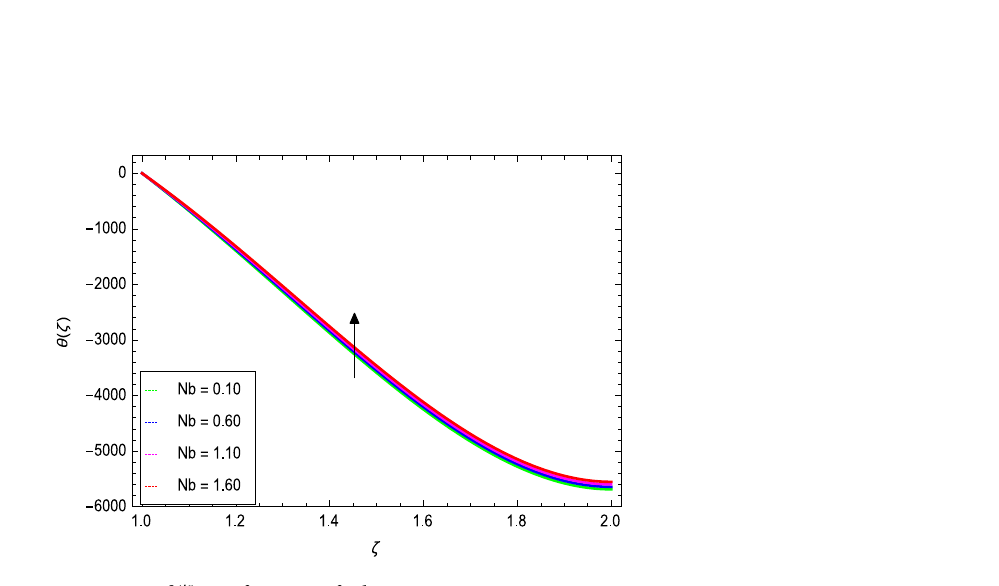
Figure 10. θ (ζ) as a function of Nb